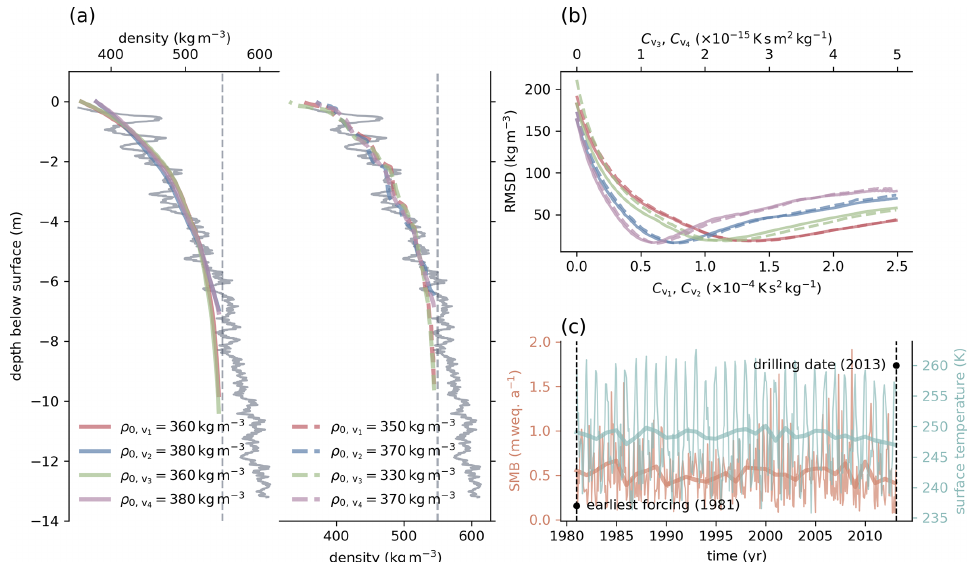
Figure 3. (a) Depth density profile (gray) of the firn core retrieved at site 3 of the iSTAR traverse (Morris et al., 2017). Colored lines show the optimal simulation results for four tested variants of the constitutive relation. The simulated density profiles on the left were obtained using yearly averaged surface forcing, whereas those on the right, plotted using dashed lines, were obtained using monthly averaged forcing. (b) RMSD between best simulation result and measured firn profile over the range of tested optimization factors C v . Colors indicate results for the different variants of the constitutive relation. Dashed lines indicate results computed with monthly averaged forcing, whereas solid lines indicate the use of yearly averaged surface forcing. (c) Forcing data from ERA5-Land monthly averaged data from 1981 to the present (Muñoz Sabater, 2019; Hersbach et al., 2020), from the earliest available forcing in 1981 to the date the firn core was drilled in 2013. Bold lines show yearly averaged data computed from monthly averaged data.